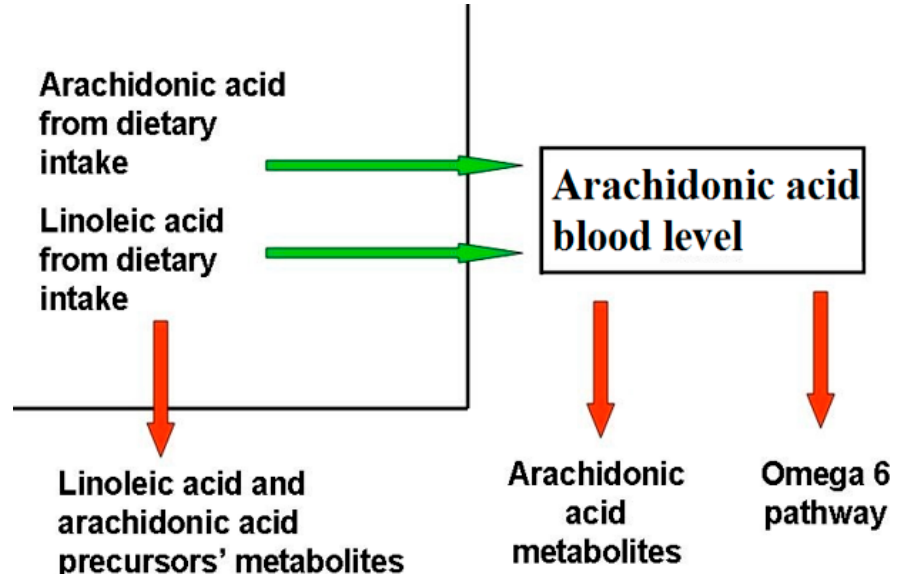
Figure 1. Factors determining blood arachidonic acid levels. The factors influencing AA levels belong to two categories, those that increase (green arrow) AA blood levels, like diet uptake and the omega-6 pathway from LA, and those that decrease them (red arrow), like the synthesis of omega-6 FA downstream AA, AA metabolization, and the reduction of AA precursors due to their metabolization. Diseases able to modify AA blood levels act through the same mechanisms.